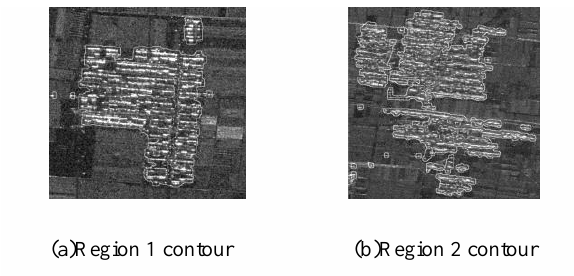
Figure 7 Contour extraction diagram of experimentation area Further, the external contours of the building area are extracted, and then the vectors are displayed to the original image, as shown in Figure 7 (a), (b). Extraction results can coincide well with the actual area. In order to carry out the quantitative analysis, we also use the method in reference [5], the evaluation method proposed two measures of detection rate and false alarm rate, which can be expressed as: